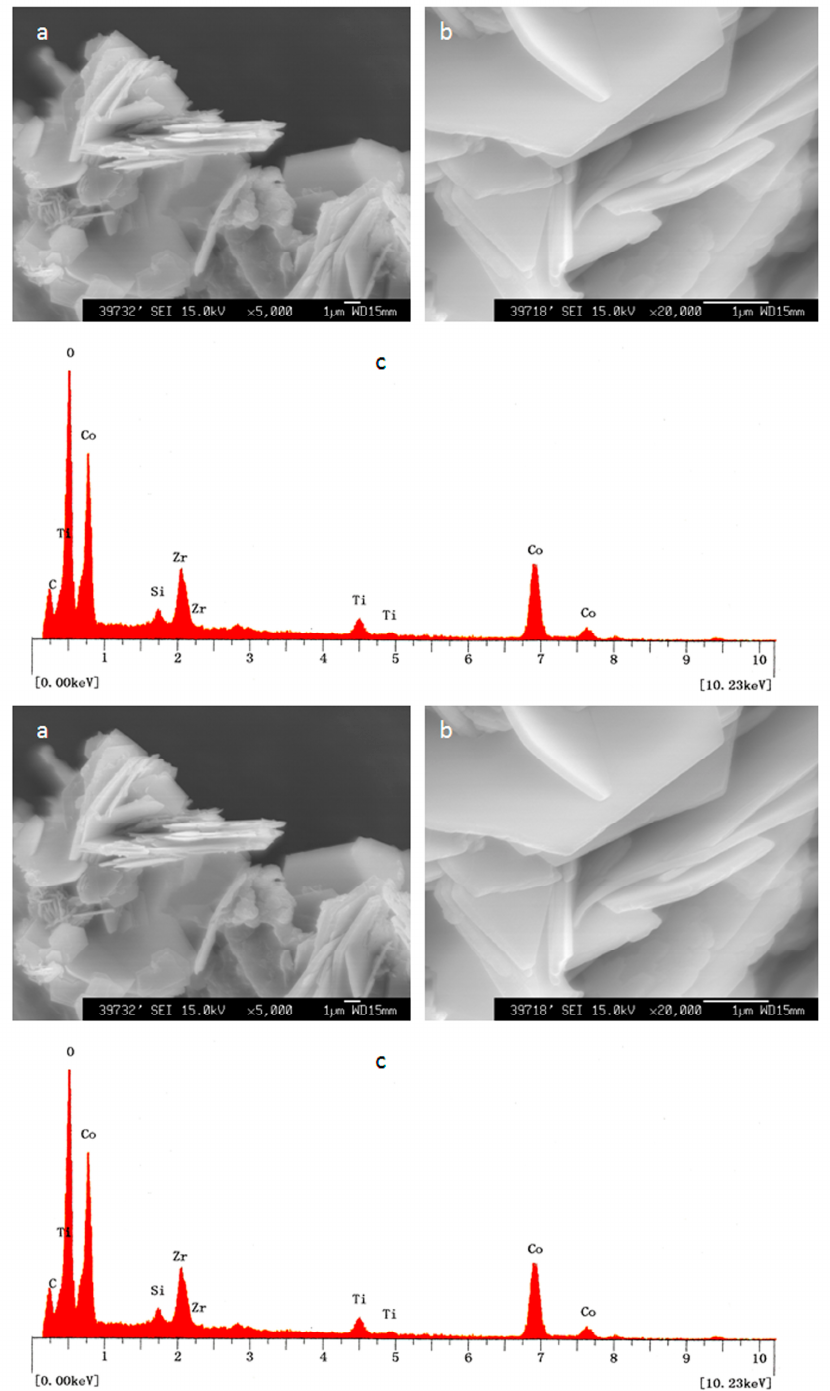
Figure 3. Co–Si LDHs after zirconium and titanium inclusion: ( a ) SEM image, ( b ) SEM image after magnification, ( c ) EDX.